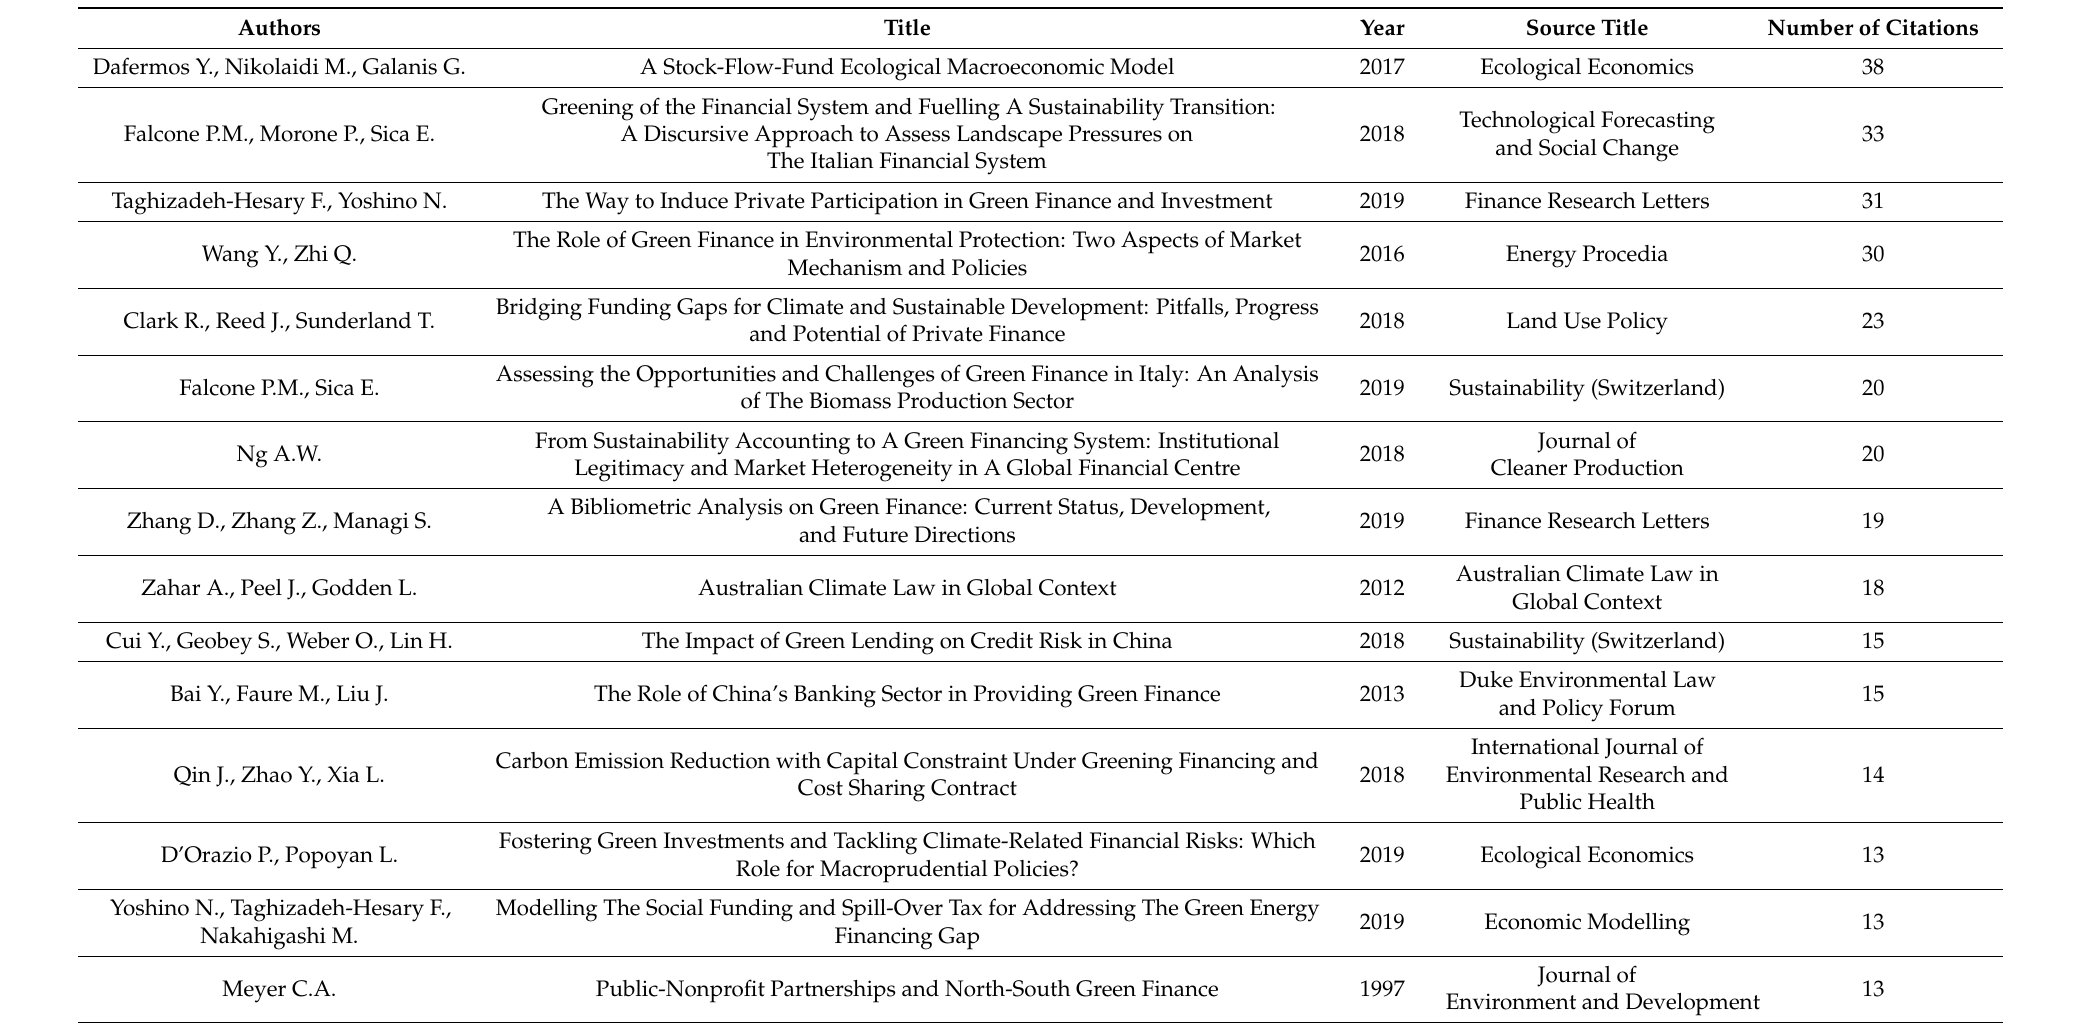
Table 6. The most-cited publication (line